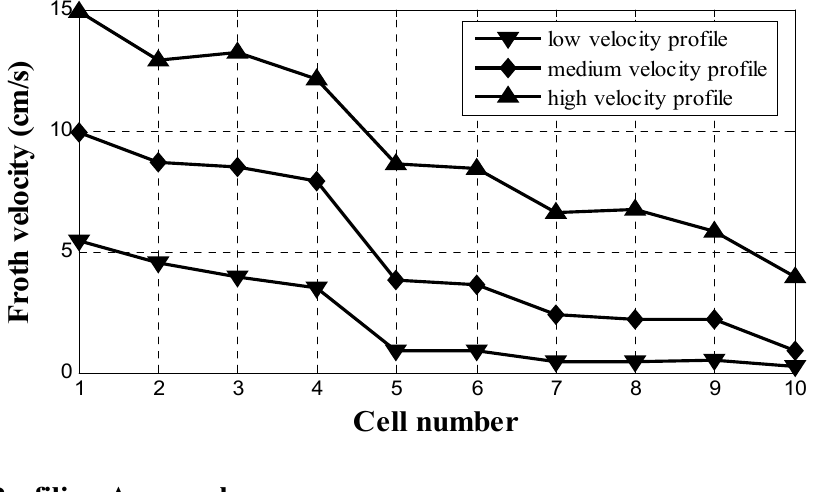
Figure 4. Average froth velocity profiles implemented at Los Colorados concentrator, Escondida Mine [19].